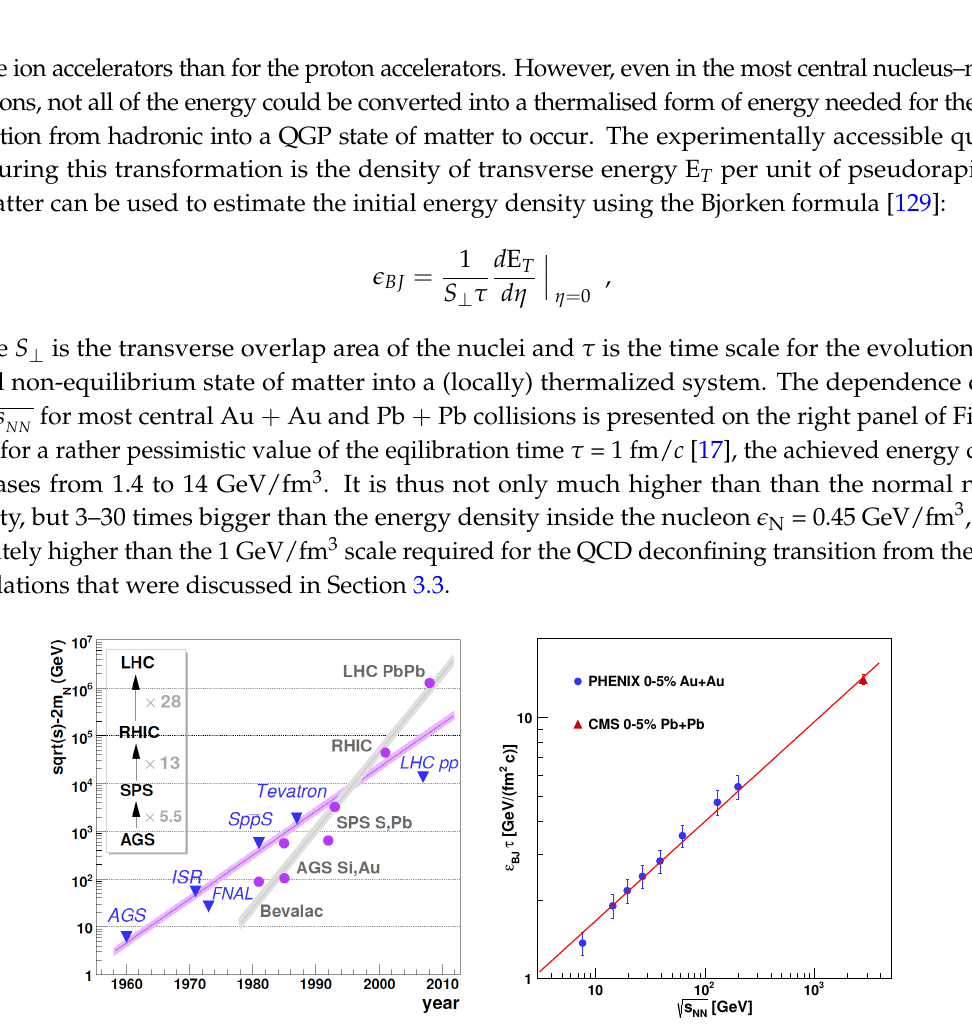
√ s -2m N versus time for (anti)proton (blue triangles) Figure 8. Left : Available center-of-mass energy and ion (magenta circles) accelerators, adapted from Ref. [71]; Right : The Bjorken estimate of the initial energy density ε BJ (Equation (32)) multiplied by τ calculated from the data on transverse energy distributions in 5% most central Au + Au [130] and Pb + Pb [131] collisions as a function of c.m.s. √ s energy per one nucleon–nucleon pair . The red line corresponds to a power law fit. From Ref. NN